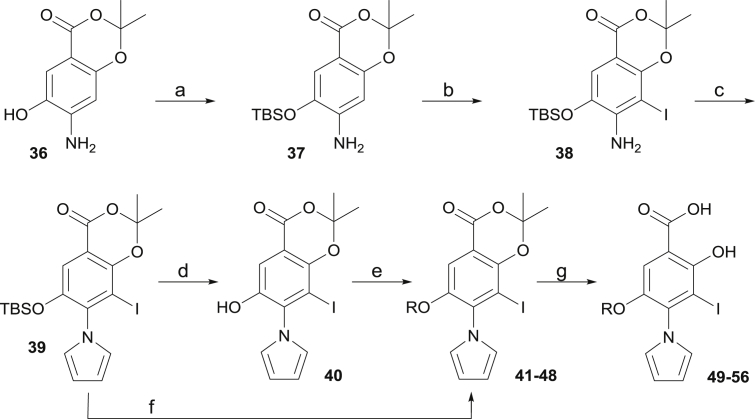
Synthesis of analogues 49–56 bearing an oxyether linker for exploration of subsite 2.aaConditions: (a) TBSCl, imidazole, CH2Cl2, 0 °C to rt, 88%; (b) NIS, MeCN, 0 °C to rt, quant.; (c) 2,5-dimethoxytetrahydrofuran, AcOH, 80 °C, quant.; (d) TBAF, DMF, rt, quant.; (e) ROH, PPh3, DEAD, THF, rt, 47–95%; (f) RI, KF, DMF, rt, 70–90%; (g) KOH, H2O/THF, rt, 71–98%.